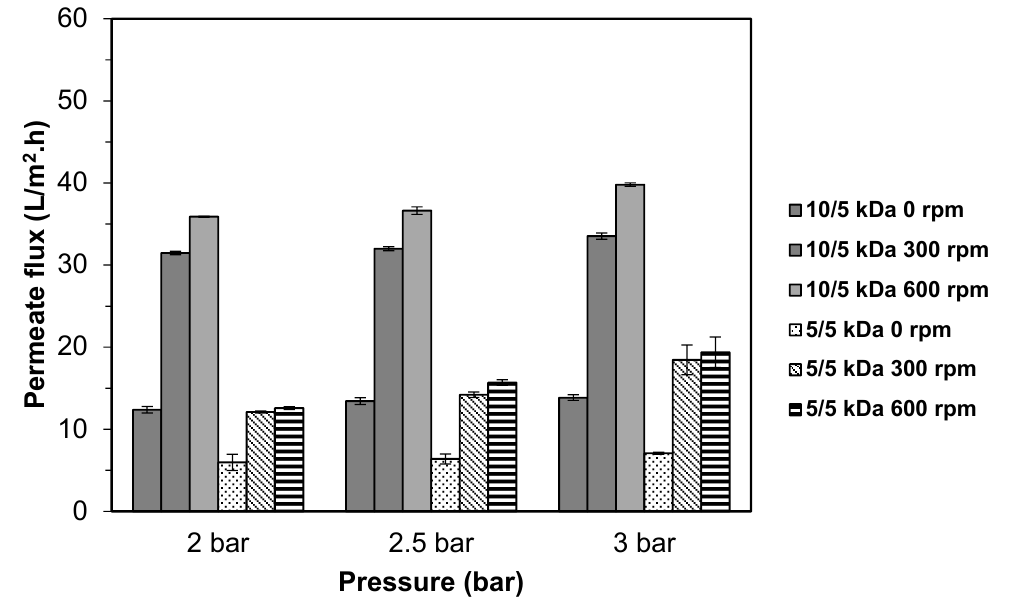
Figure 2. Permeate flux of TB protein hydrolysate using multilayer ultrafiltration (UF) membranes at different stirring speed.